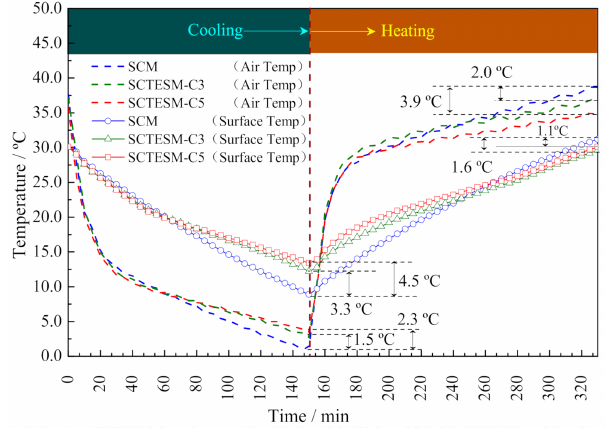
Figure 15. Thermoregulating performance of